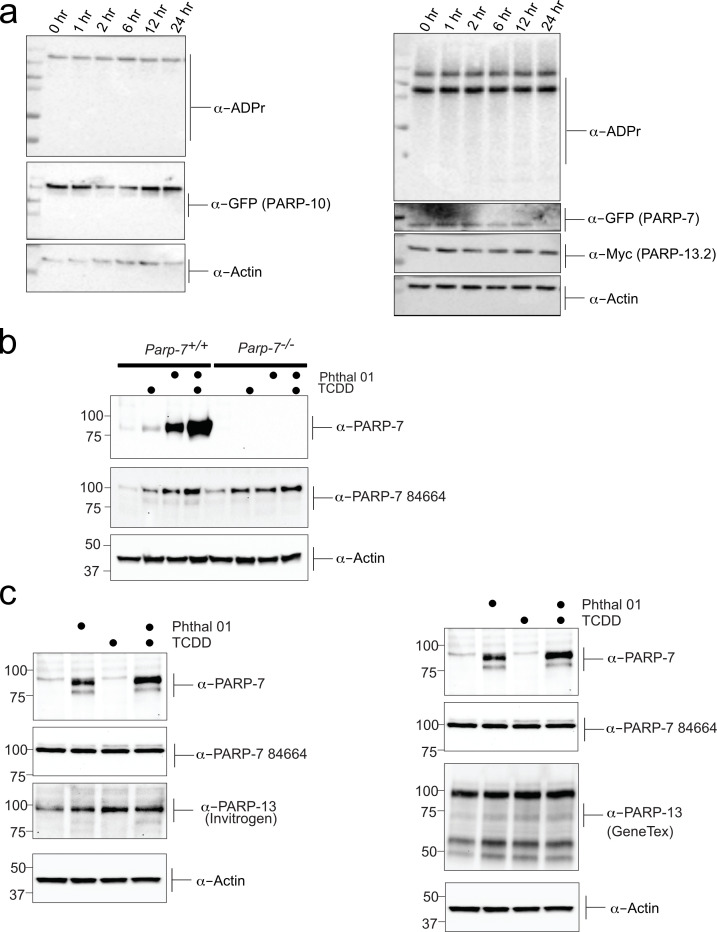
Inhibition of PARP-7 catalytic activity stabilizes PARP-7 protein levels.(a) Chemical stability of ADPr modification. The chemical stability of PARP-7 and PARP-10 mediated ADPr was assessed by performing a time course post denaturation of HEK293T cellular lysates. Cells we transfected with GFP-PARP-7 and MycX2-PARP-13.2 or GFP-PARP-10, lysed, heat denatured in SDS and allowed to sit at room temperature for the indicated times. Proteins were resolved by SDS-PAGE and were detected by Western blot using antibodies against ADPr, GFP, and actin (b) Validation of PARP-7 (TIPARP) antibody in MEF cells (+/+) and (-/-) PARP-7 cells. Cells were treated with TCDD (2,3,7,8 -Tetrachlorodibenzo-p-dioxin) was used to induce PARP-7 and Phthal01 (24 hr treatment) used to inhibit PARP-7. Proteins from the resulting lysates were resolved by SDS-PAGE and were detected by Western blot using antibodies against novel PARP-7 (TIPARP), commercially available Anti-PARP-7 antibody (ab84664), and Actin. (c) Further investigation of endogenous PARP-7 and PARP-13 response to Phthal 01 PARP-7 inhibitor. Cells treated with TCDD (2,3,7,8 -Tetrachlorodibenzo-p-dioxin) was used to induce PARP-7 and Phthal 01 (24hr treatment) was used to inhibit PARP-7. Proteins from the resulting lysates were resolved by SDS-PAGE and were detected by western blot using antibodies against novel PARP-7 (TIPARP), commercially available Anti-PARP-7 antibody (ab84664), Invitrogen PARP-13 (ZC3HAV1 Antibody PA5-31650), GeneTex PARP-13 antibody (ZC3HAV1 antibody [N3C2]), and Actin.